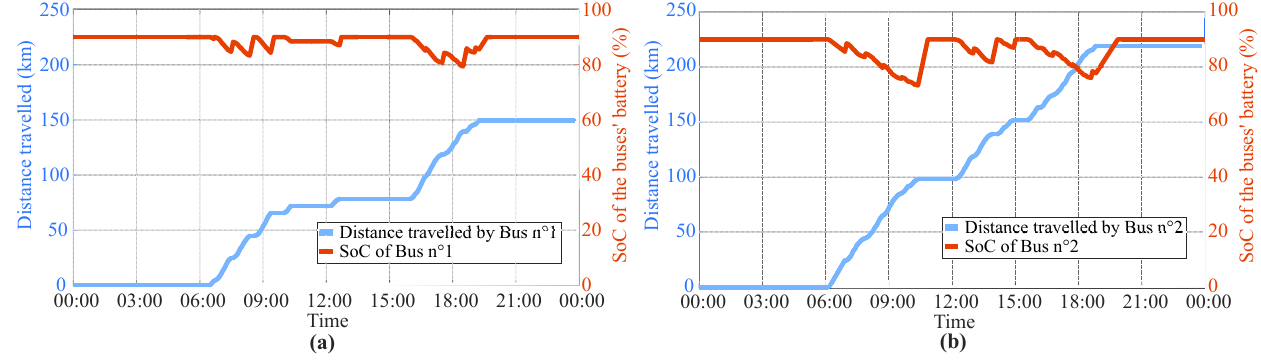
Figure 10. Travelled distance and battery SoC of buses n°1 ( a ) and n°2 ( b )—scenario 2. It can be seen in Figure 11 that the two buses recharge during a short period at line terminals, usually not at the same time. However, the total charging power reaches 300 kW for 4 min at 18:36 when both buses are charging at bus terminals and 200 kW for 3 min at 19:02 when bus n°2 arrives at the terminal and bus n°1 is at the depot. The charging process occurs mainly during the day, when electricity is produced by PV panels. As for PV energy, 81 kWh are used directly to charge buses during the day, but additional stationary storage would increase the PV share during the day and allow the use of PV energy during the night.